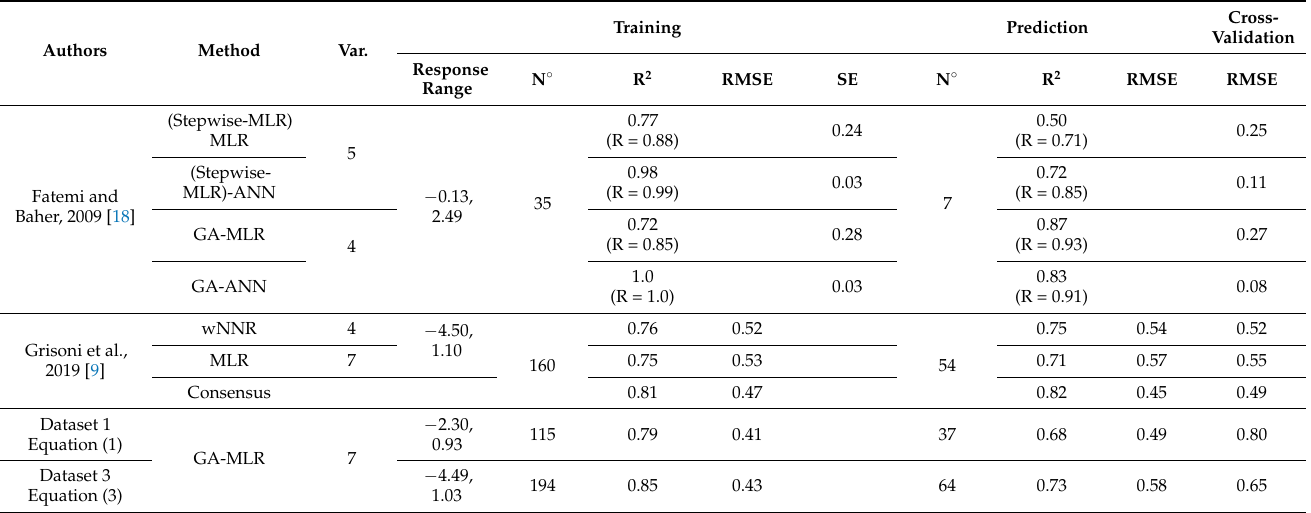
Table 5. Comparison of the statistical results of the QSAR models found in the literature with the models proposed in this study for the prediction of dietary Log BMF in fish. MLR: multiple linear regression, ANN: artificial neural network, GA: genetic algorithm, wNNR: weighted nearest- neighbour